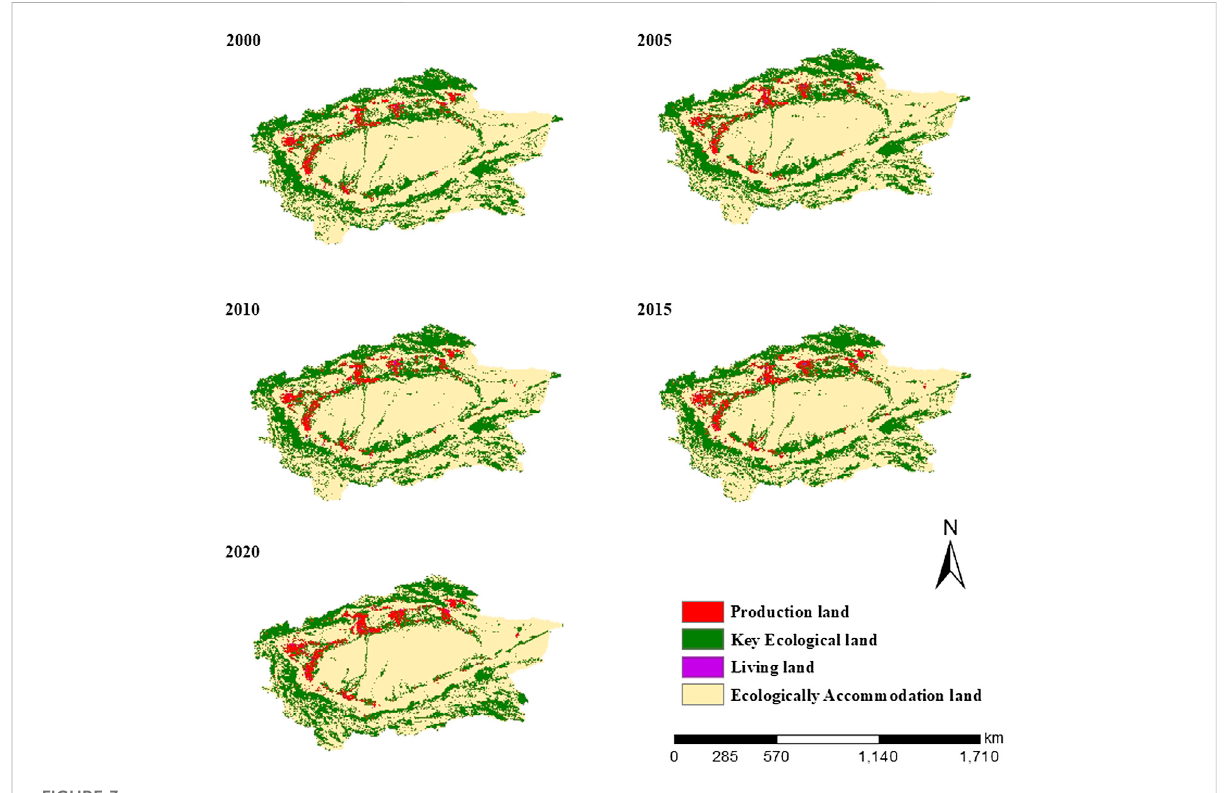
FIGURE 3 Spatial distribution of land use status based on